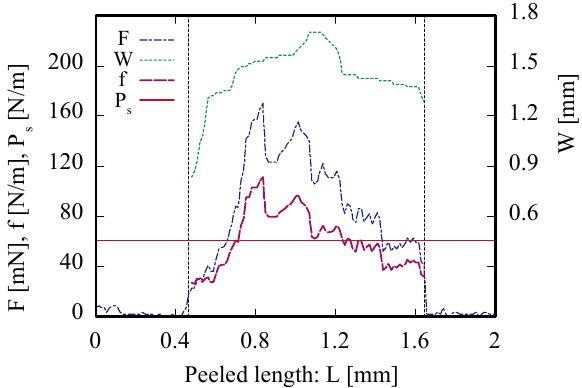
Fig. 8 Example of a peeling load-displacement diagram.